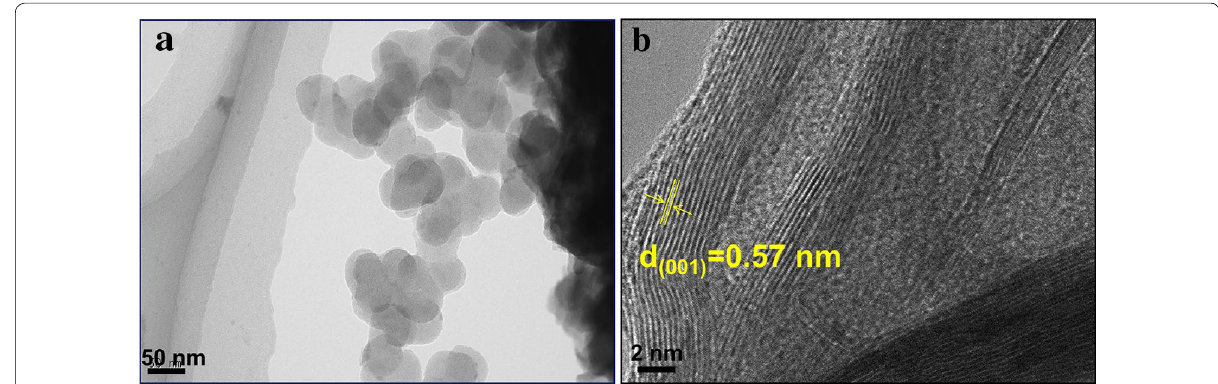
Fig. 3 The low and high‑magnified TEM images for 1%/VS 2 sample